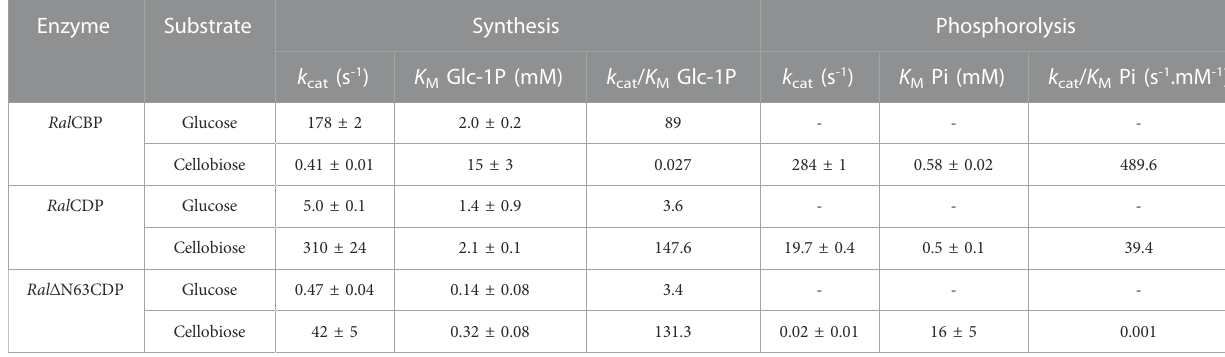
TABLE 2 Kinetic parameter for Glc-1P and Pi from the different enzyme variants. Enzyme Substrate